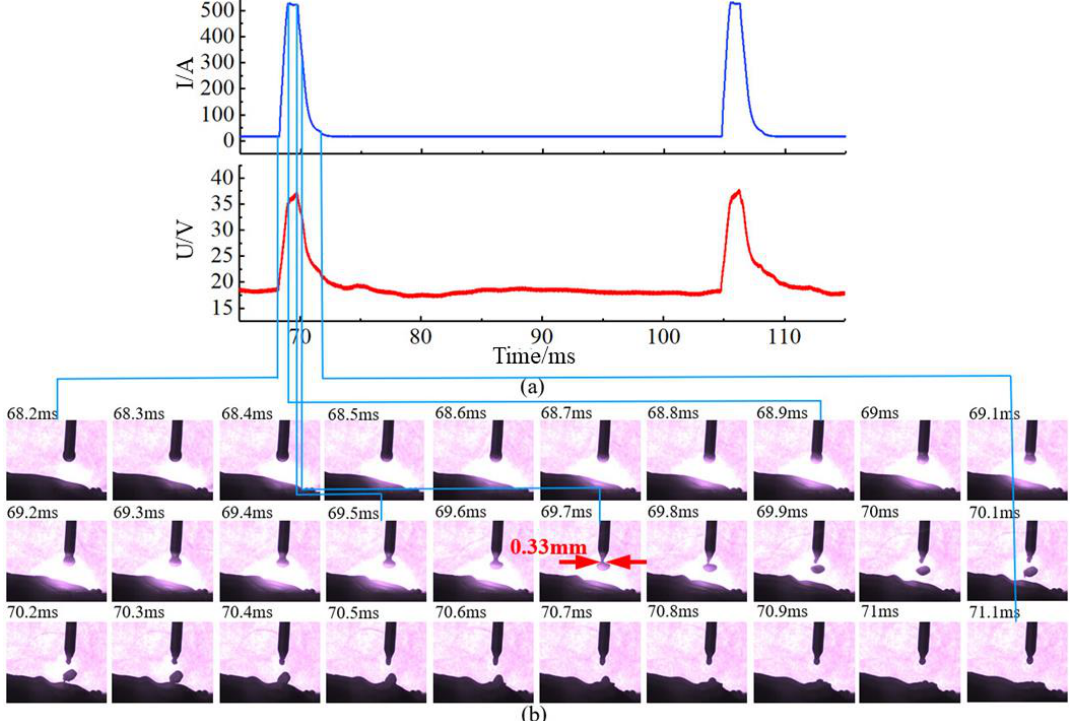
Figure 7. P-GMAW current and voltage signal and arc and droplet transition behavior photographs ( I p = 525 A): ( a ) current and voltage signal; ( b ) synchronous photographs. The increase of I p lead to the decrease of pulse frequency with the same average cur- rent (under the condition of 60 A welding current, I p = 485 A, f = 40 Hz, I p = 525 A, f = 30 Hz), and higher I p accelerate the melting droplet from the welding wire. As shown in Fig- ures 6 and 7, it takes 2 ms from the beginning of the pulse to the moment when the droplet is released from the wire with I p = 485 A, and the shrinking neck diameter before the drop- let is 0.22 mm, while it takes 1.6 ms with I p = 525 A, and the shrinking neck diameter before the droplet is 0.33 mm. The results show that with the higher I p , the shorter the time it takes, and the larger the diameter of the shrinking neck as the droplet to detangle from the wire. Figure 8a shows the droplet and arc size at different times during a single pulse pe- riod ( I p = 485 A). The change process of heat and force acting on the weld pool can be calculated by combining Equations (6) and (11) with the current and voltage data in Figure 4, as shown in Figure 8b. The D P is synchronized with the current, however, at the moment when the droplet detaches from the wire, a peak occurs in the D P curve, which is due to the increase of metal vapor concentration in the arc space resulting from by the droplet detaching from the wire. The D R Curve first falls and then rises at the peak pulse stage because the arc root is always located at the shrink neck between the welding wire and the droplet. The droplet gradually grows and forms a shrink neck, and the size of the arc root decreases gradually. As the droplet detaches, the shrink neck disappears, and the size of the arc root increases. The arc thermal power also has the same variation trend as the current curve, as shown in Figure 8b. The arc pressure increases rapidly with the rise of the current and presents a brief stable stage similar to the current waveform after reaching the peak value. The peak arc pressure is nearly 580 Pa. With the current falling to the base value, the arc pressure falls back and maintains at nearly 5 Pa. The impact of the droplet acting on the weld pool at a fixed frequency can be equivalent to equivalent force, as shown in Equation (11). However, the solidification process of the weld pool is a phase